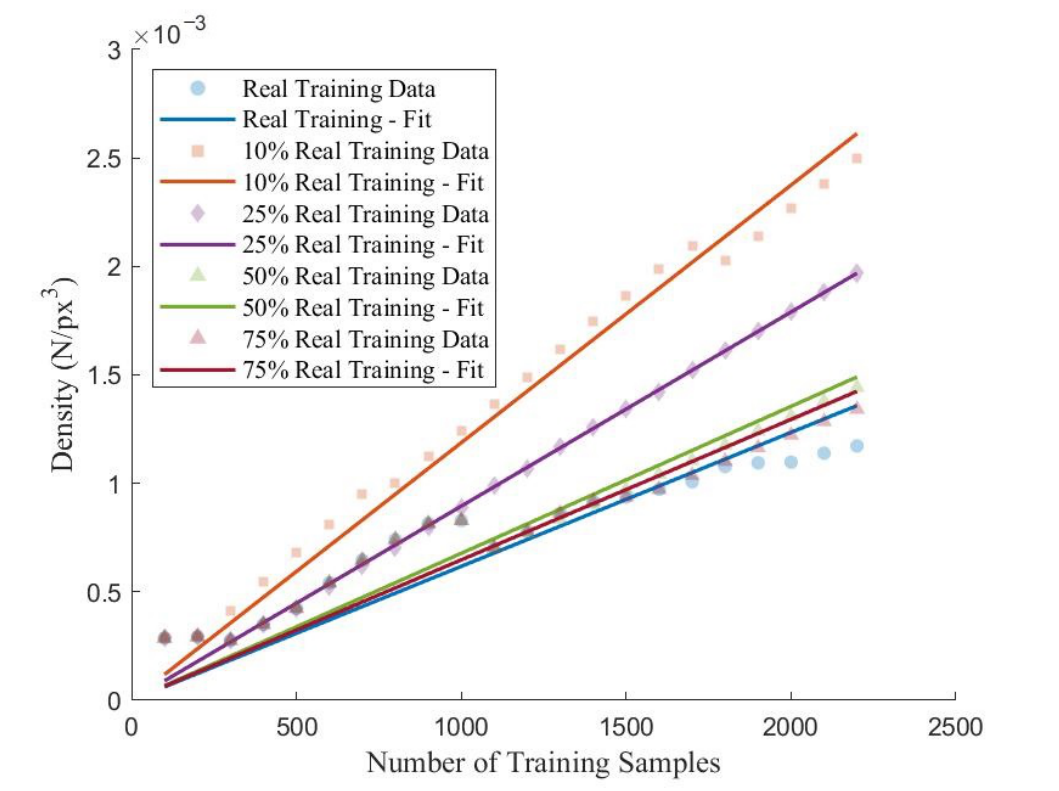
Figure 10. Training dataset cluster density for various synthetic image ratios for all